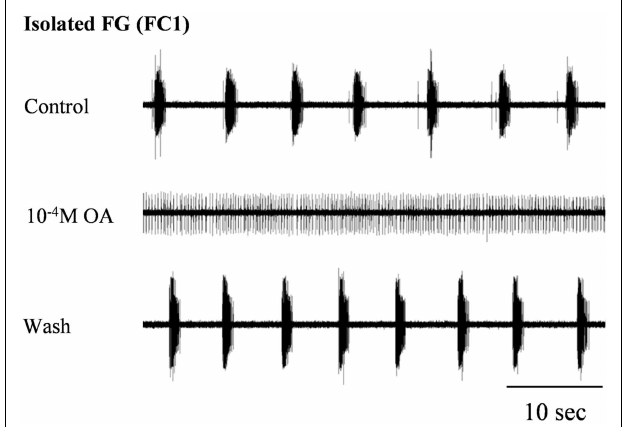
FIGURE 2 |The disruptive effect of octopamine on the rhythmic activity of the in vitro isolated FG. Extracellular recording from the FG efferent nerve, FC1, before and during bath application of 10 − 4 M OA as well as after wash. OA application resulted in the replacement of HG rhythmic activity by tonic